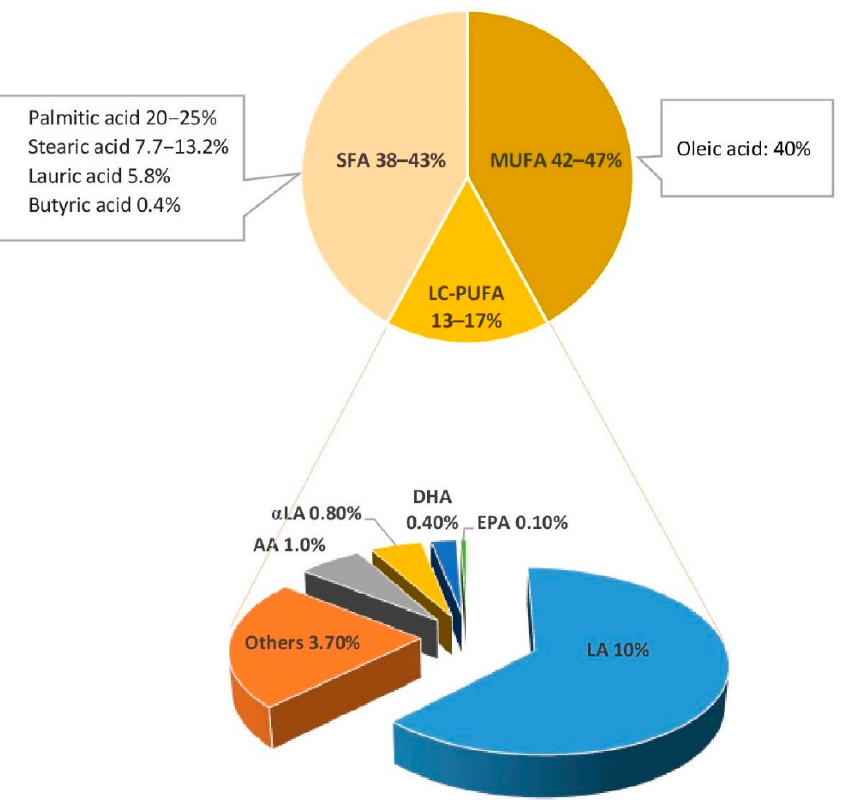
Figure 1. Fatty acids of breastmilk. SFA, saturated fatty acids; MUFA, mono unsaturated fatty acids; LC-PUFA, long chain-poly unsaturated fatty acids; LA, linoleic acid; α LA, α linolenic acid; AA, arachidonic acid; EPA, eicosapentaenoic acid; DHA, docosahexaenoic acid [23,24] .